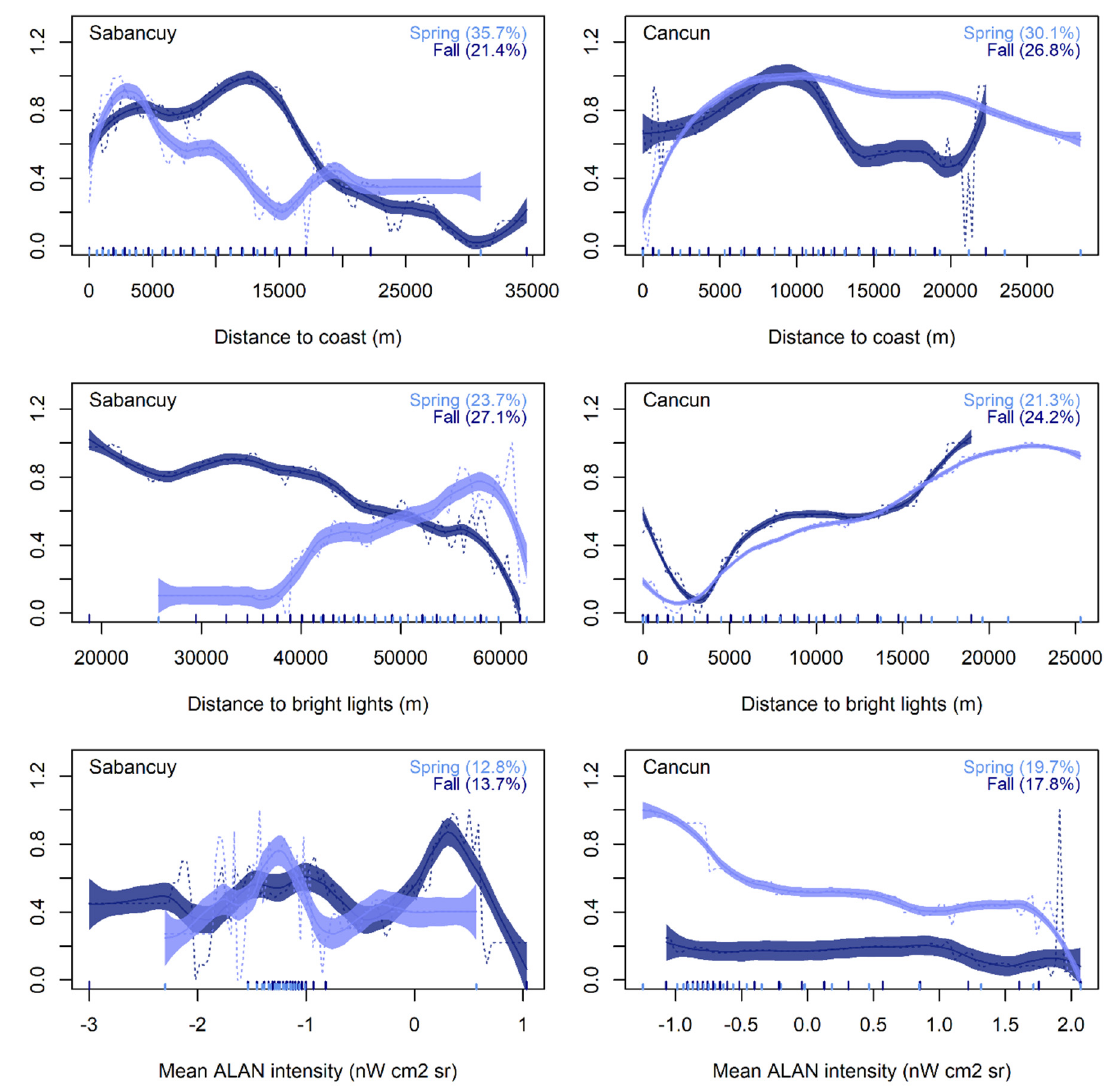
Figure 2. Partial dependency plots of distance to coast, distance to bright lights, and mean intensity of artificial lights at night (ALAN) in relation to bird densities around the Sabancuy and Cancun weather radars in the southern Gulf of Mexico in spring and fall migration seasons. Solid lines and thick curves are the mean ± 95% CI of the smoothed original trend line from the Boosted Regression Tree models, shown as dotted lines. Numbers in parenthesis show the relative importance of the predictor for each season after removing non-biologically important predictors. Y-axis represent a measure of bird densities around radars scaled from zero to one for easy comparison of the relationships. X-axis of mean ALAN intensity is log 10 -transformed. Rug plots on the x-axis show deciles of the distribution of predictor values for each radar. Plots of all other predictors included in models for each radar and season are available in Figures S4 to S7. Color version of figure is available online.